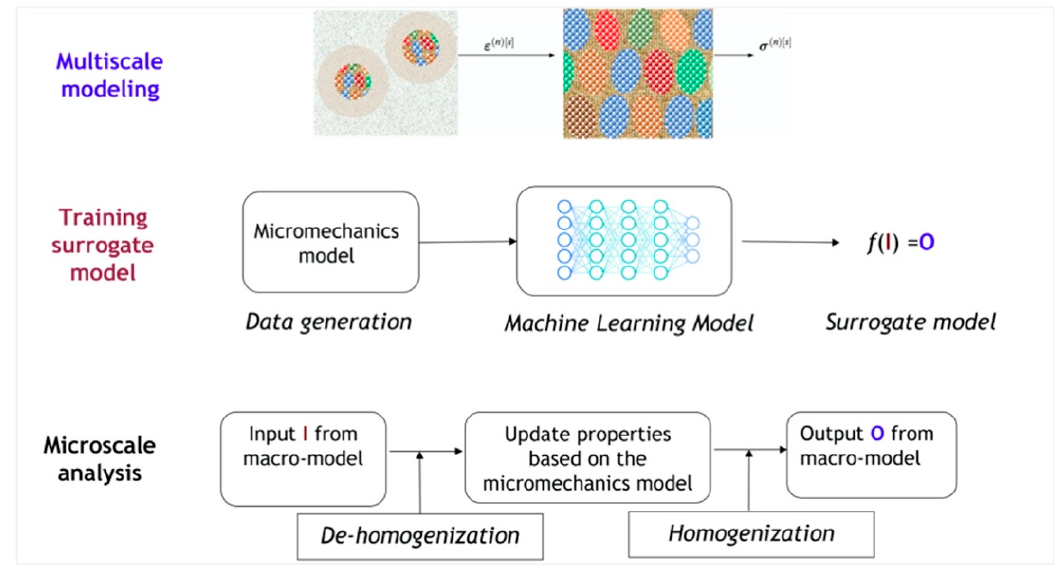
Figure 18. General framework of data-driven multiscale modeling that bridges micro- and macro- scales. Training machine learning surrogate model based on data generated by micromechanics models for prediction of macroscale mechanical behavior of nanocomposite with various nano/micro-structural features.